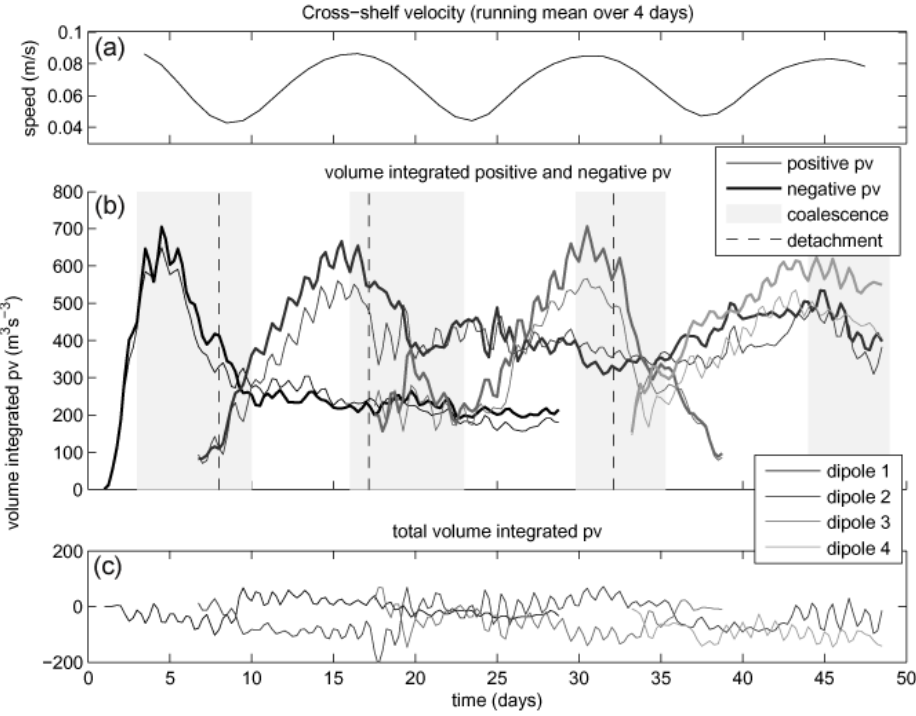
Fig. 13. (a) Spring-neap envelope of the cross-shelf tidal velocity near the cape. (b) Volume-integrated PV for each of the positive and negative PV eddies in the large dipoles. The horizontal volumes over which this integration is accomplished are shown in Fig. 3; the integration is performed vertically between the surface and ρ = 26 kgm − 3 . Both the middle and lower panels show that the amount of PV contained in each eddy of the dipole is approximately equal. The dashed line indicates when the dipole has detached from the cape; this measure is highly imprecise, having simply been obtained by eye; errors on order of one day are likely. (c) Sum of positive and negative vorticity in the dipole pairs.